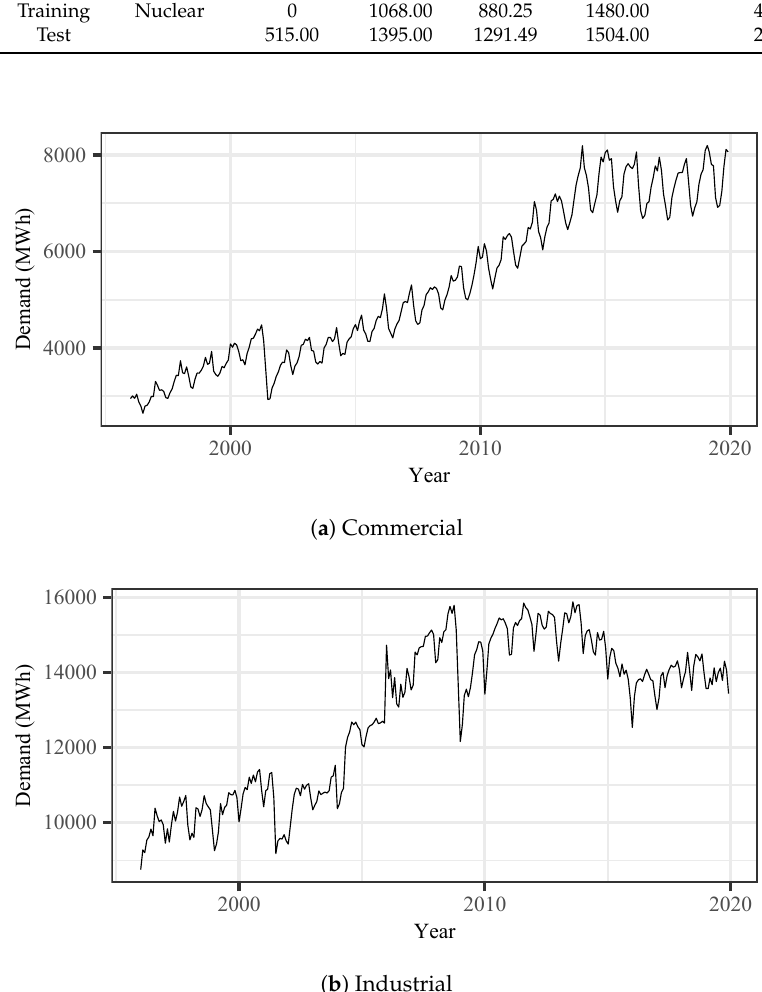
Figure 2. Brazilian electricity